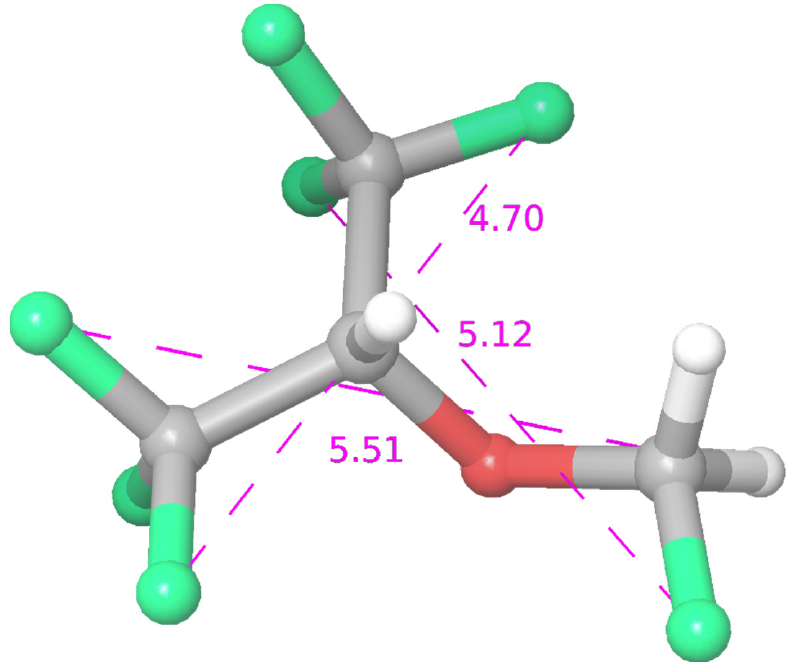
Figure 1. Schematic drawing of sevoflurane.